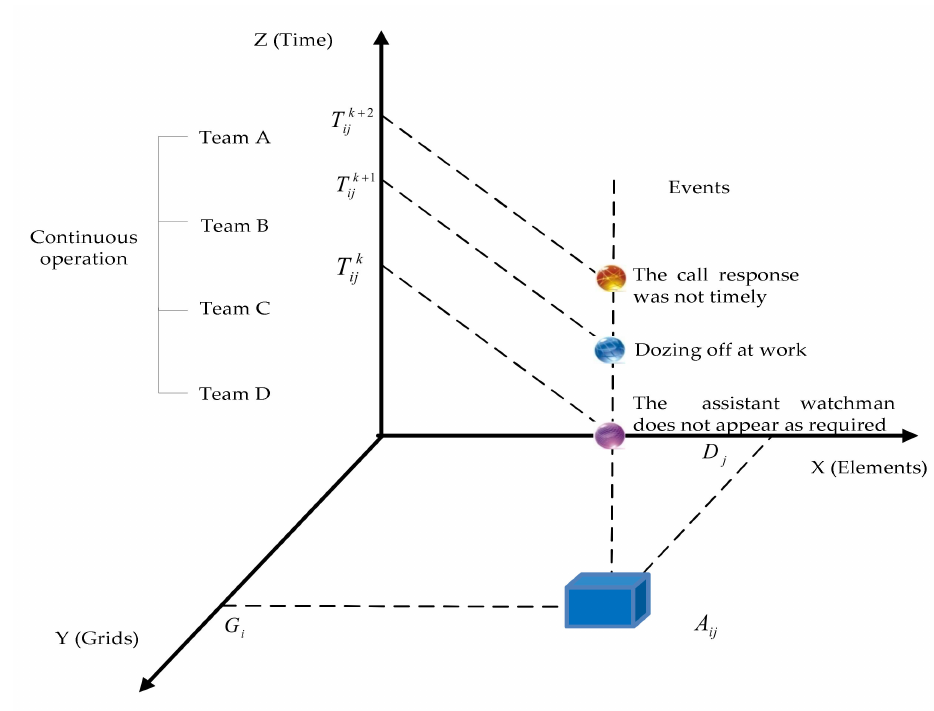
Figure 2. Grids, elements, and events